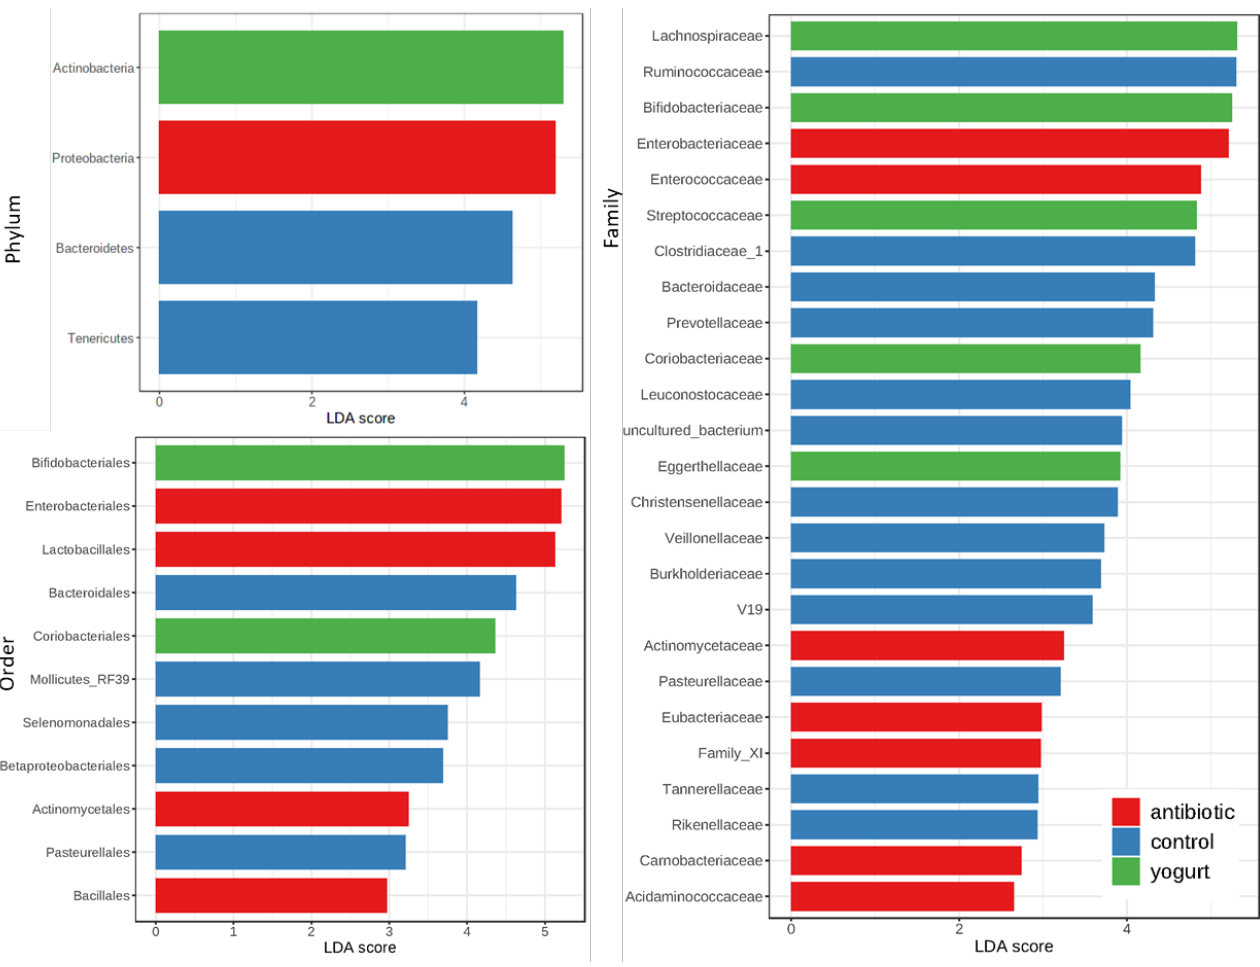
Figure 3. Biomarkers of different taxa level of the Gut Microbiome among antibiotic usage, Yogurt consumption and control (LEfSe analysis).